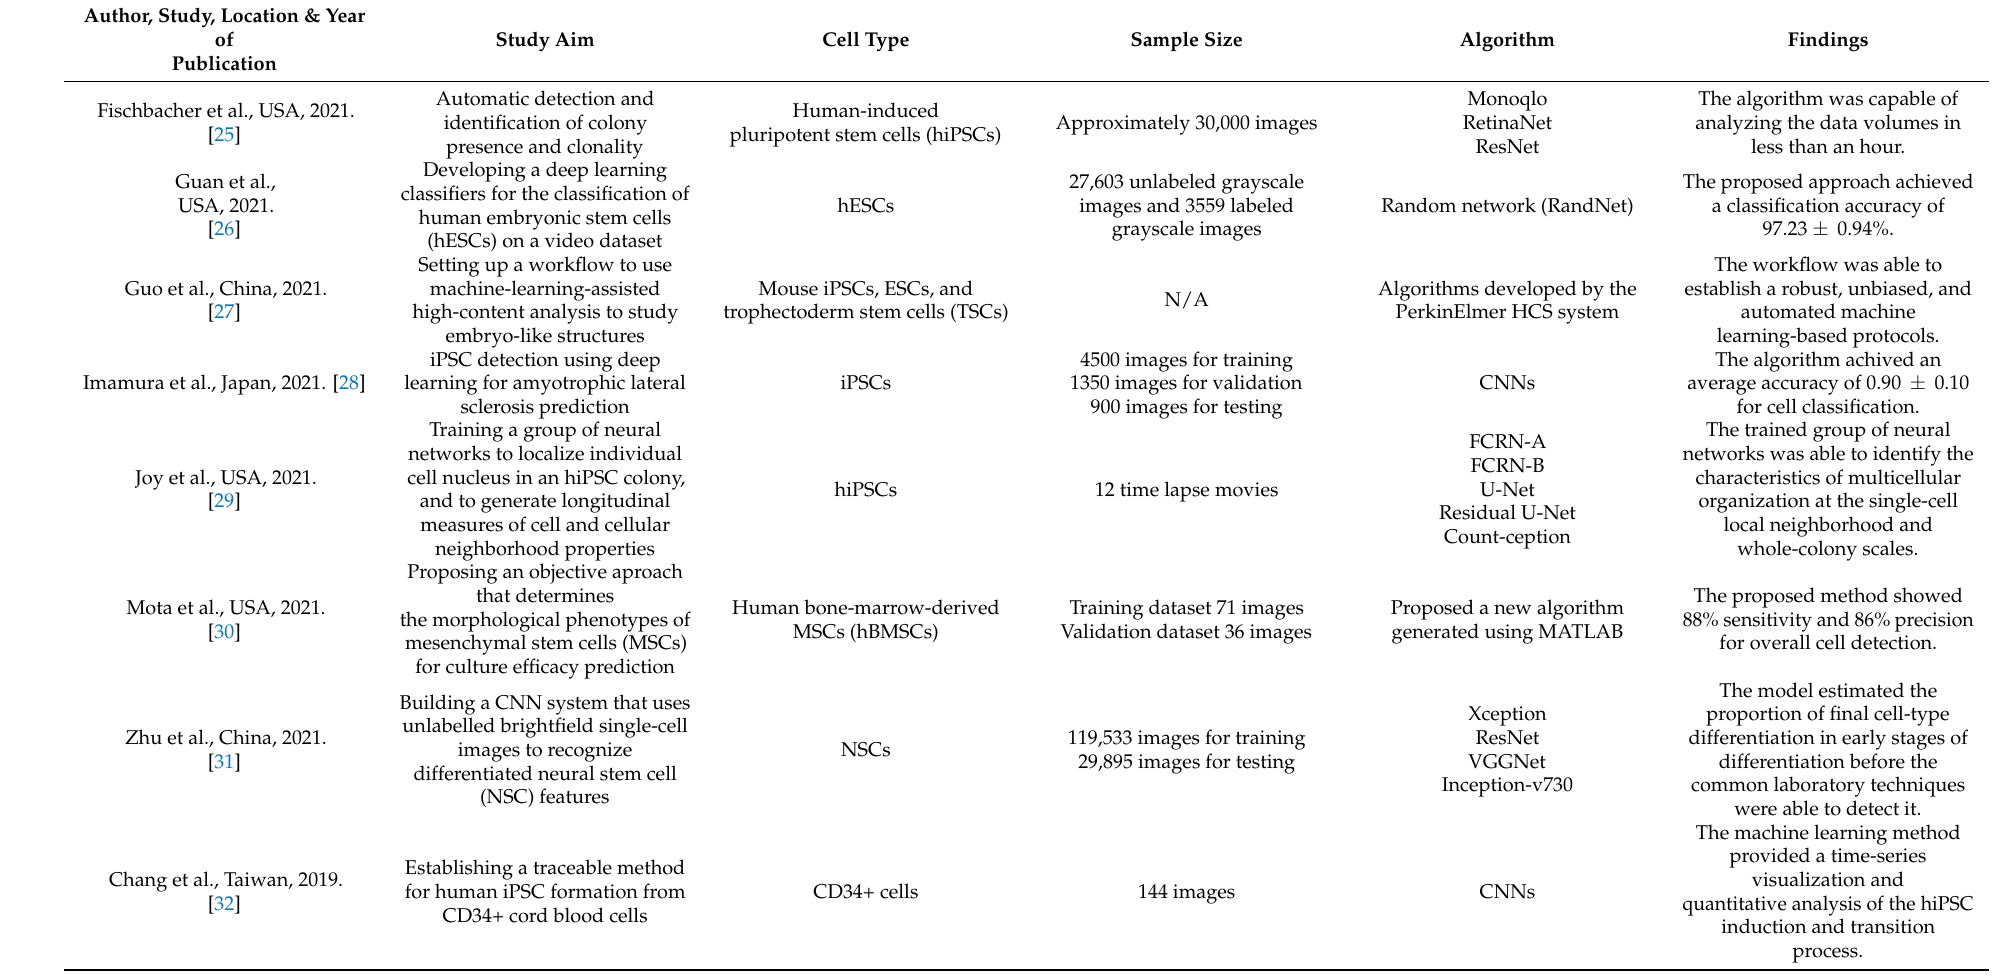
Table 2. Data extracted from included